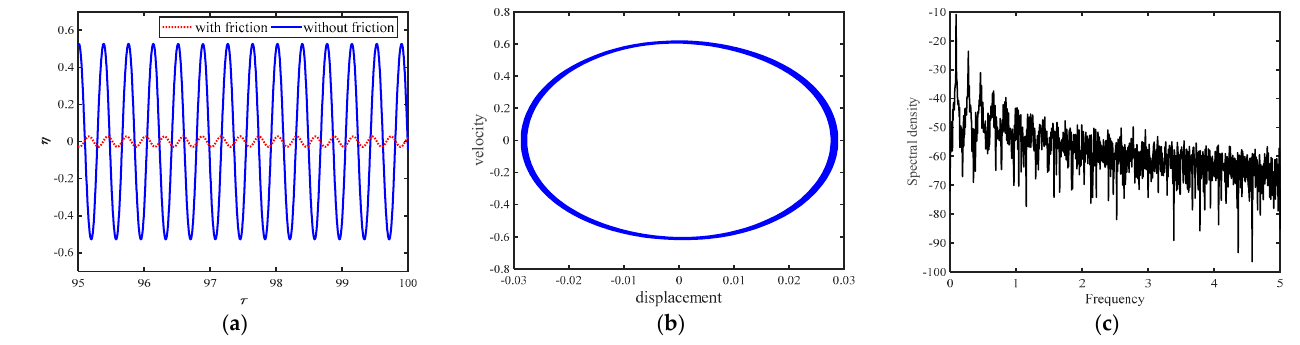
Figure 7. Dynamic response of the pipe with dry friction at the tip − end of the pipe when u = 7.8 and ξ d = 0.3: ( a ) time history curve; ( b ) phase portrait; ( c ) PSD curve.